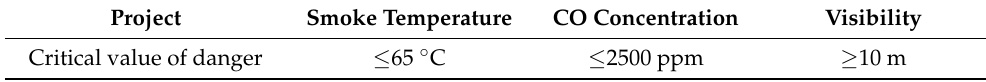
Table 1. The critical value of related